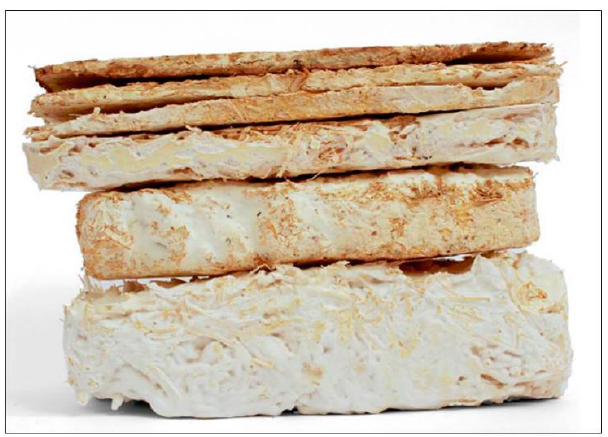
Figure 3. Mycelium-based composite (Source: Wikimedia Commons).